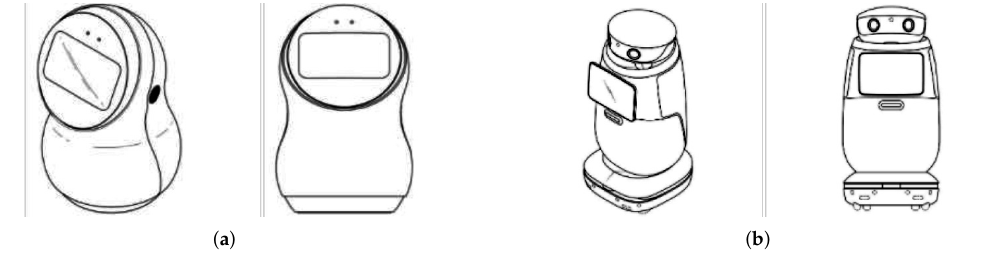
Figure 2. Domestic robot LG: ( a ) Patent 1 [38]. ( b ) Patent 2 [39]. Social